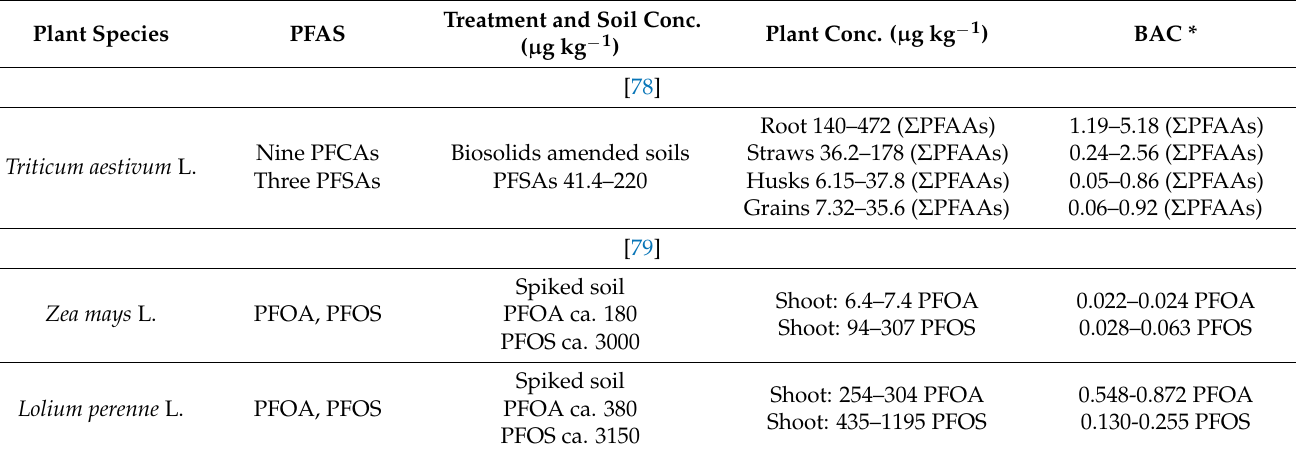
Table 4. Response of plants to PFAS compounds * in field